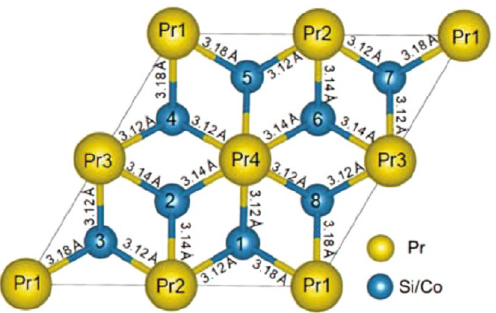
Figure 4. 2D-view of Pr 2 CoSi 3 structure ( AlB 2 -type) showing the positions 1–4 for Pr atoms (yellow) and 1–8 for Si/Co-site (light blue) in configuration I.